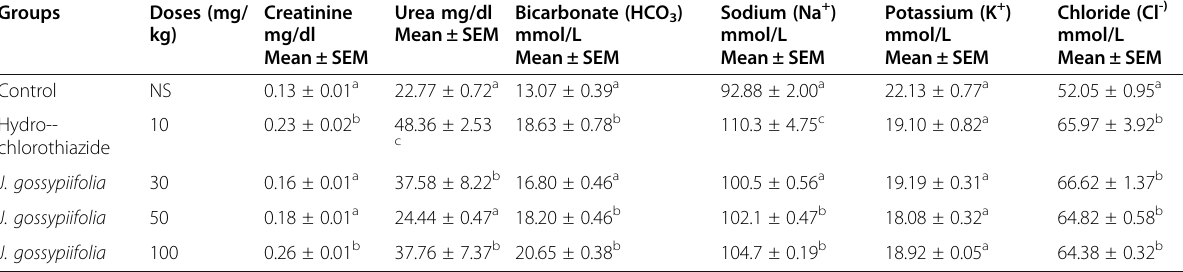
Table 1 Effect of J. gossypiifolia (JG) on renal function test in urine